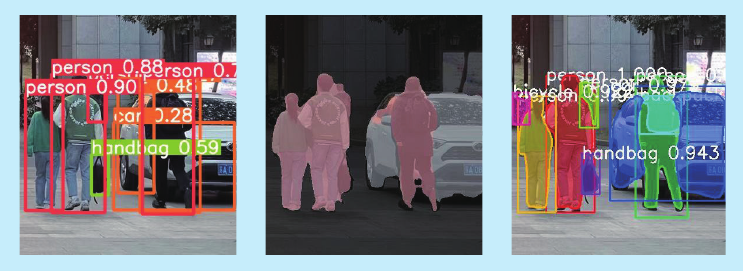
Figure 18. From left to right are the test renderers of YOLOv5, Deeplabv3, and Mask